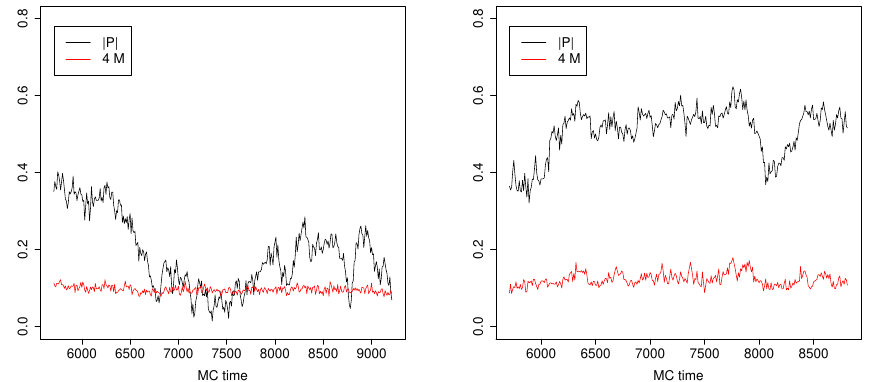
Figure 18. Full BMN model: µ = 1 . 6 , N = 32 , L = 24 , T = 0 . 452 . Starting from the same initial configuration, a confined and deconfined stream is obtained from two different random number generator seeds. For these runs, no constraint on the Myers term is imposed and the simulation remained in the trivial